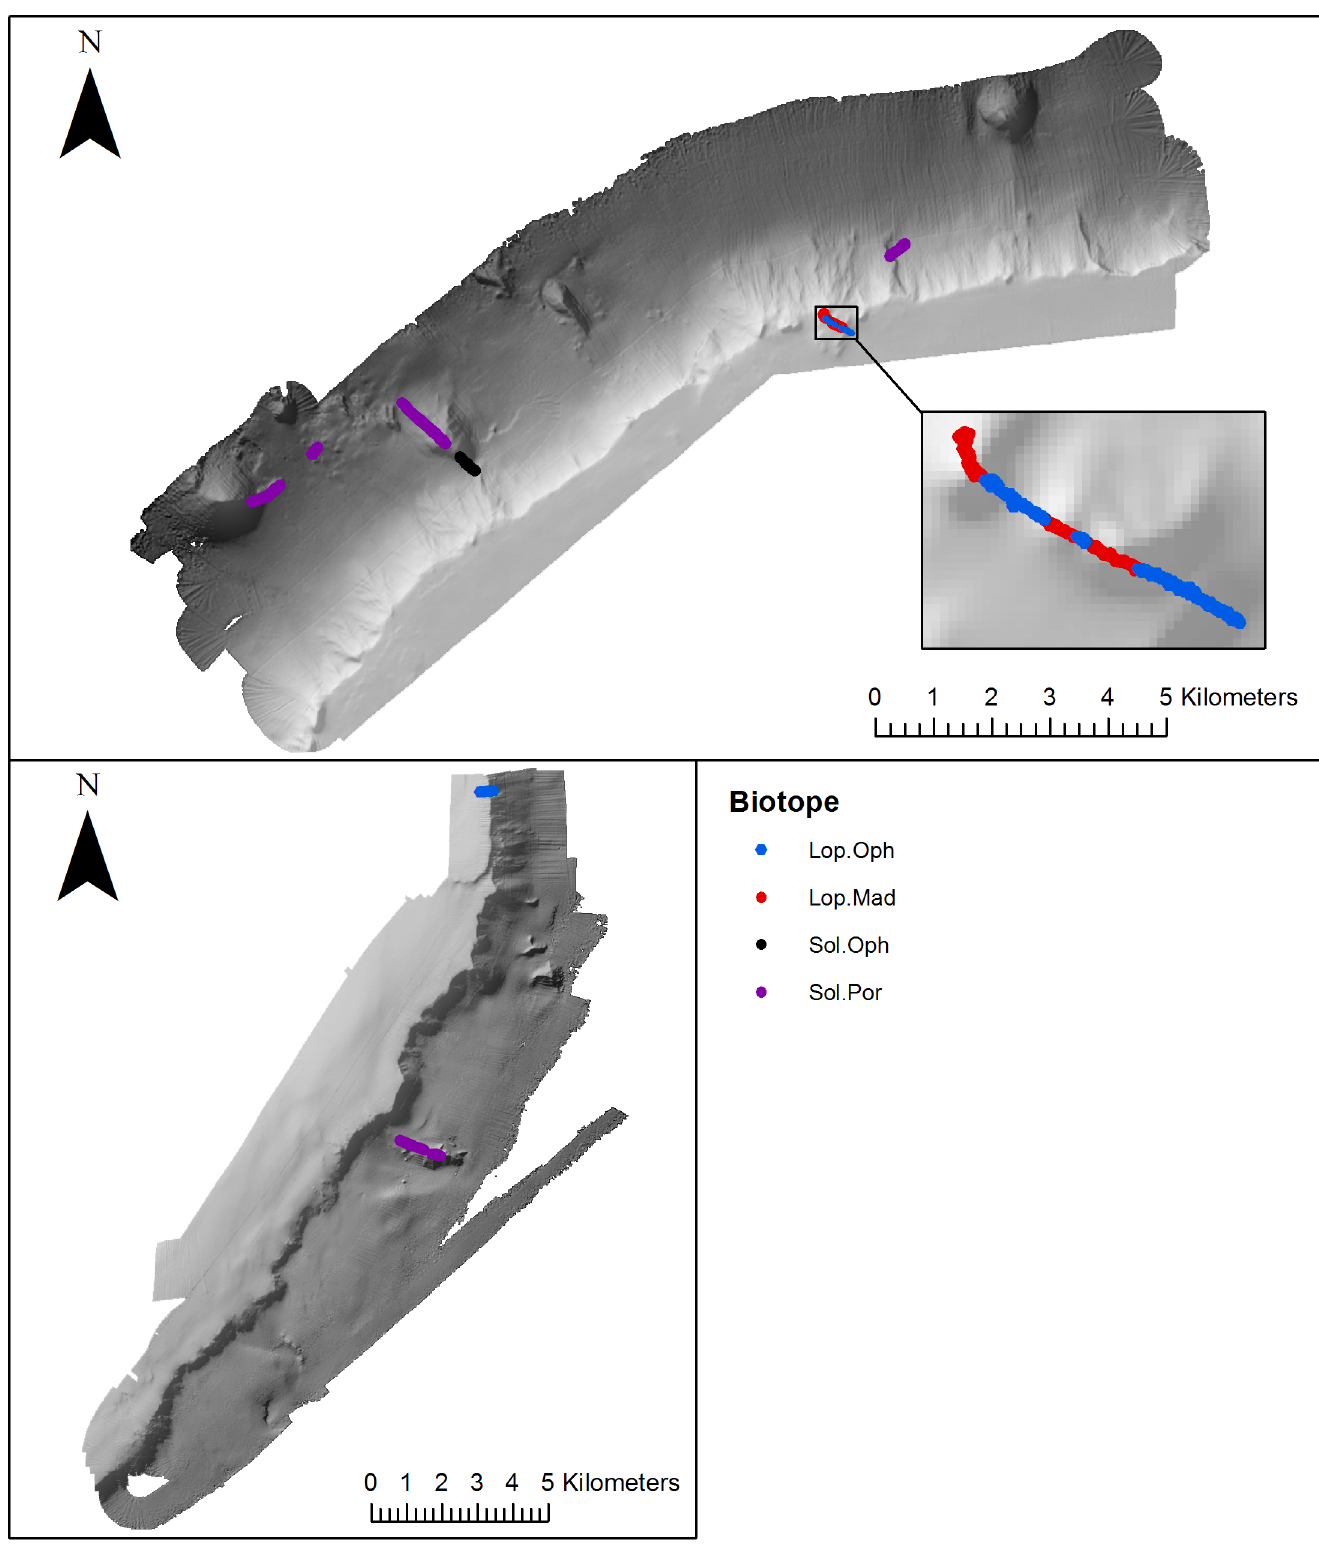
Fig 7. Distribution of cold-water coral reef (mapped using video footage) biotopes on the NW and SE side of Anton Dohrn Seamount. Refer to Fig 2 for bathymetric scale.